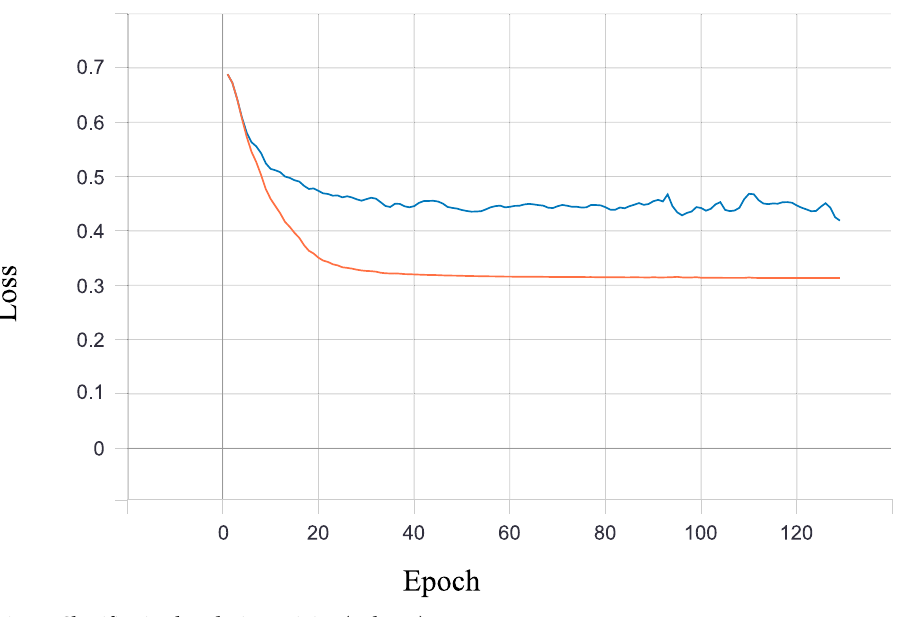
Results calculated for a test set (accuracy, precision and recall) are gathered in S5–S7 Tables.